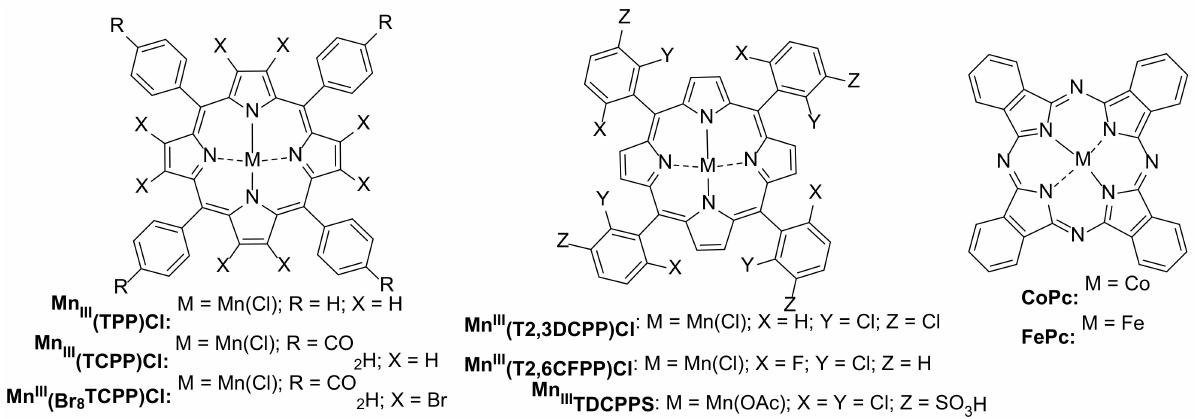
Figure 4. Structures of tetrapyrrolic macrocycles (TPM) used as catalysts for oxidative chemical degradation of